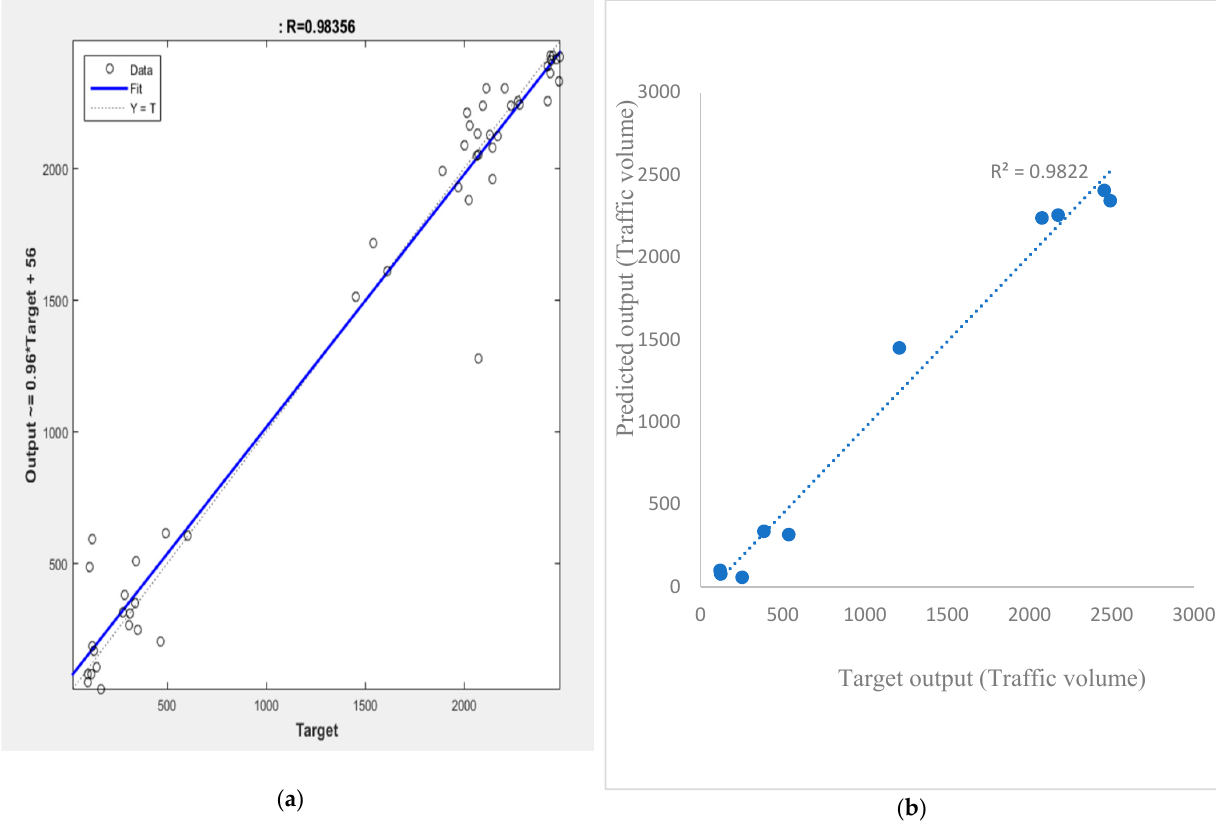
Figure 9. ( a ) ANN-PSO training response of the best performance neural network of the traffic datasets of the roadsites (13-5-1). ( b ) Comparison between the measured and predicted traffic volume of the roadsites for the testing performance of the ANN-PSO model.